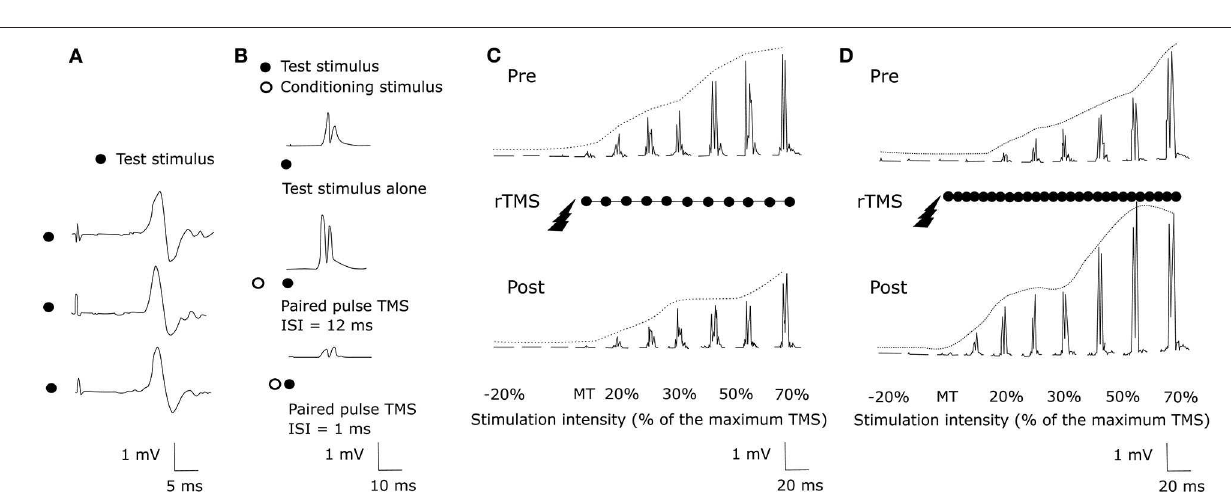
FIGURE 9 | TMS methods (131). (A) spTMS (B) ppTMS (C) low frequency rTMS (D) high frequency